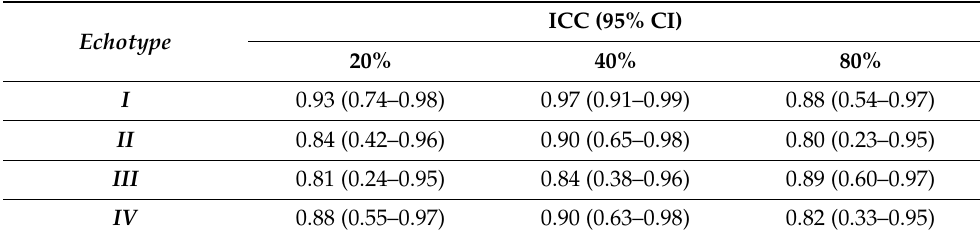
Table 1. Interclass correlation coefficient of UTC scan of the patellar